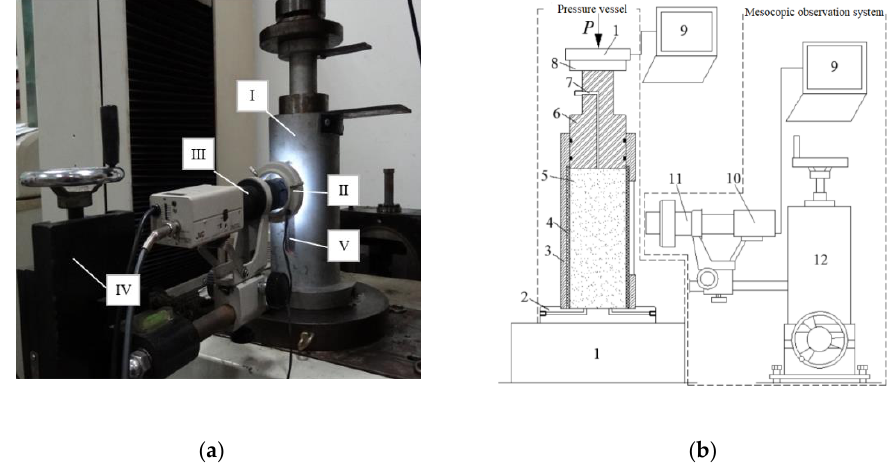
Figure 6. Observation apparatus for mesomechanics and deformation of tailings. ( a ) Photo: I. pressure chamber and accessories; II. ring lamp; III. stereomicroscope and charge coupled device camera; IV. 3D movable observation support frame; and V. observation window. ( b ) Schematic [36]: 1. loading indenter; 2. bottom plate; 3. stainless steel cylinder; 4. tempered glass cylinder; 5. tailing specimen; 6. pressure piston; 7. exhaust hole; 8. piston pressure head; 9. computer; 10. charge coupled device video camera; 11. stereoscopic microscope; and 12. 3D movable observation support frame.